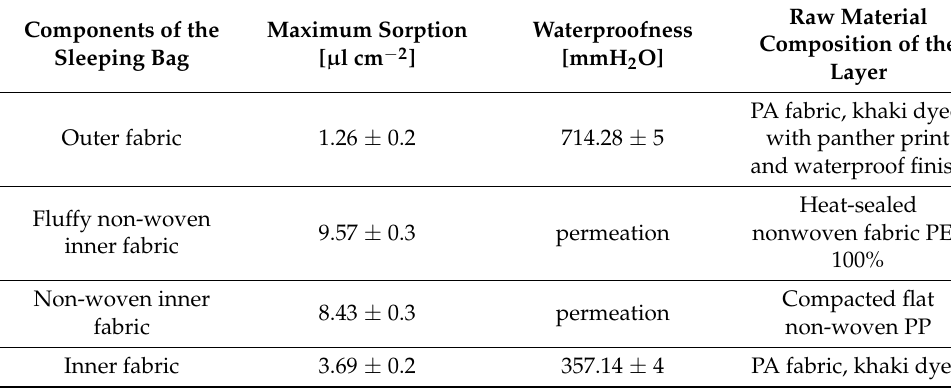
Table 10. Test results of sorption and waterproof properties. Components of